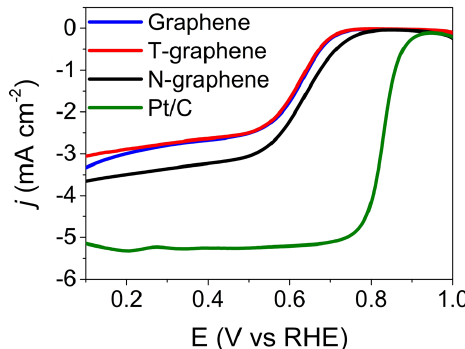
Figure 3. Cyclic voltammograms of the electrocatalysts in N saturated 0.1 M KOH at 50 mV s -1 .